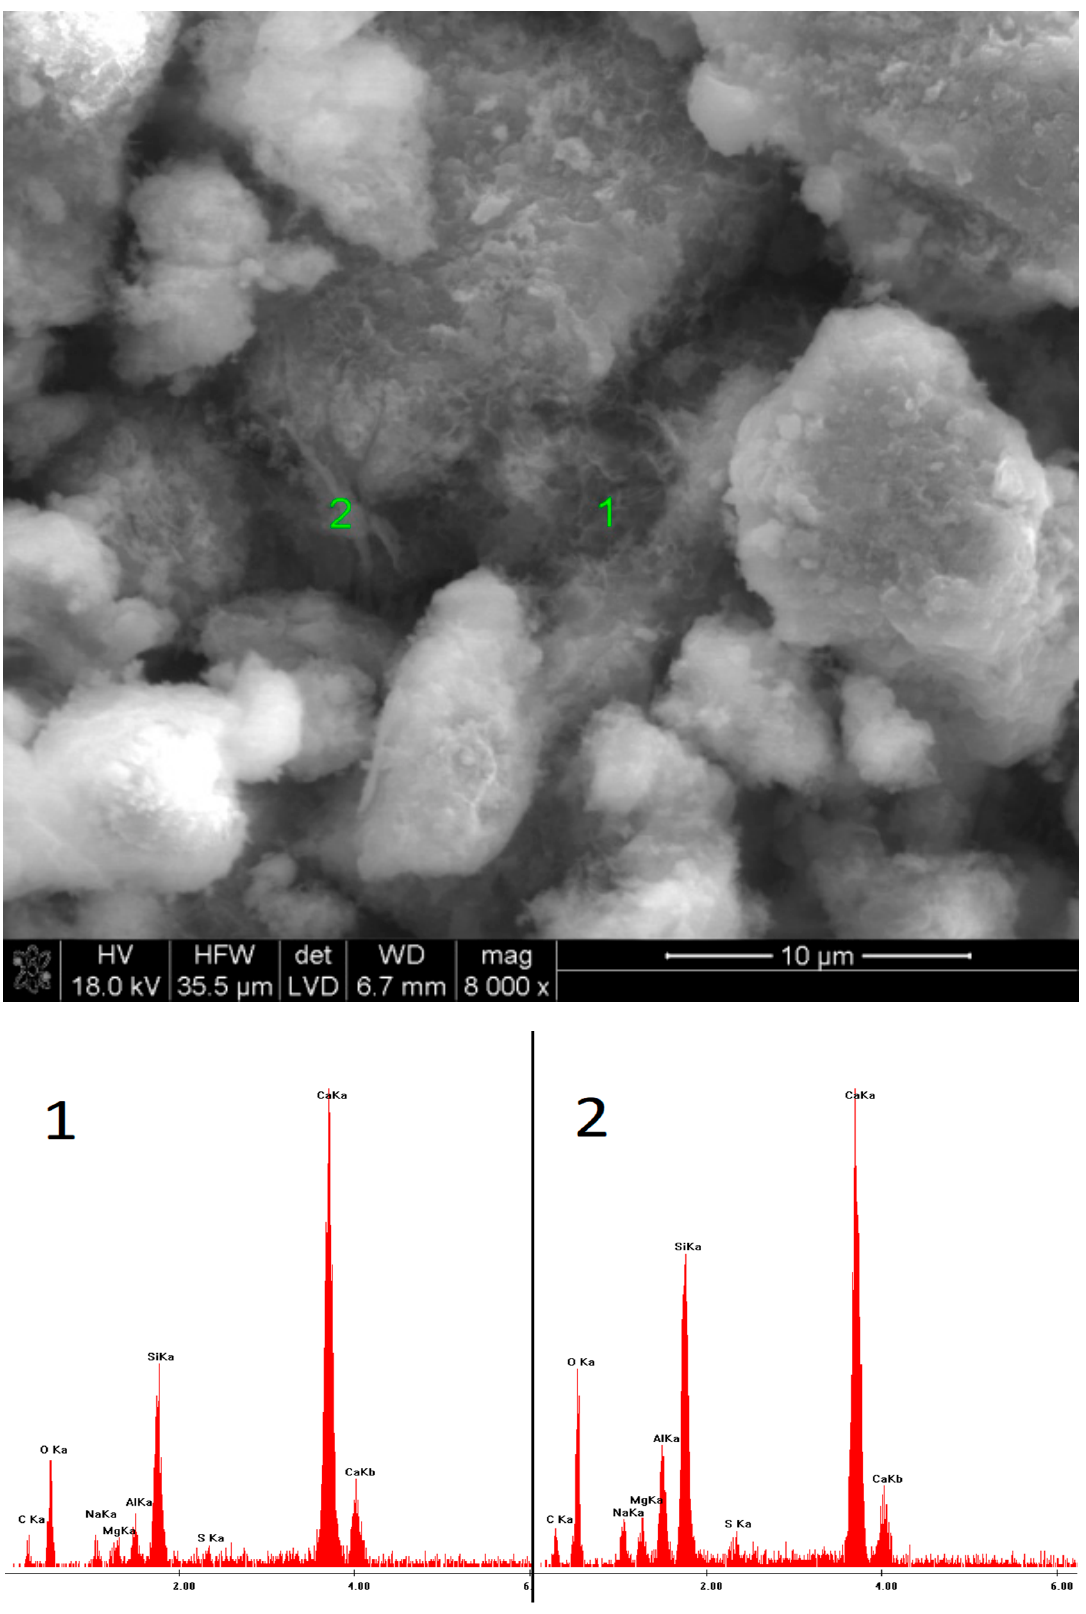
Figure 16. Microstructure of slag paste activated with sodium nitrate after 360 days of curing—SEM + EDS; 1 , 2 —hydration products covering the slag grains.